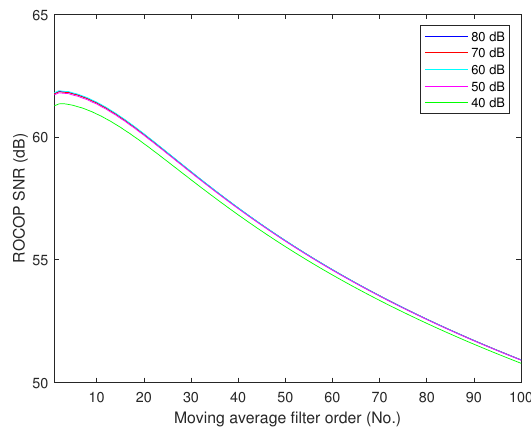
Figure 12. ROCOP SNR versus MA filter order for different SNR